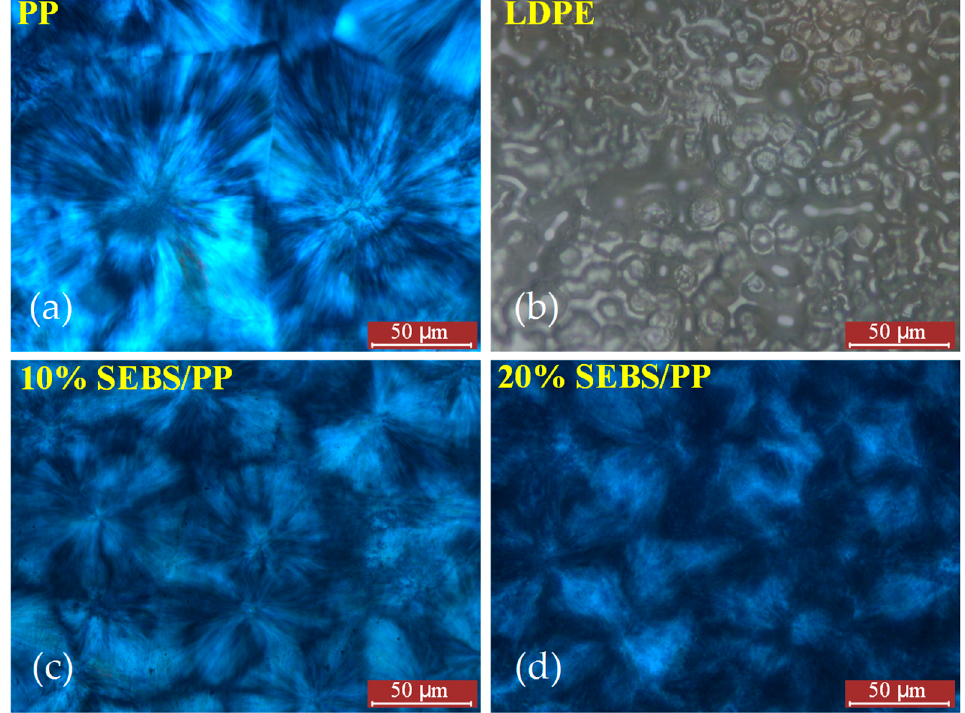
Figure 4. Spherulitic crystalline structures observed by the optical microscope for LDPE in normal mode and for PP and SEBS/PP composites in polarizing mode: ( a ) PP, ( b ) LDPE, ( c ) 10%SEBS/PP composite and ( d ) 10%SEBS/PP composite. Molecules 2020 , 25 , x